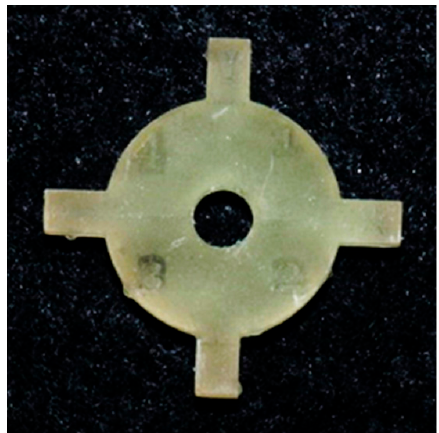
Figure 7. Final printed coupon in the resin for surgical guides (Dental SG Resin, Formlabs, Somerville, MA).